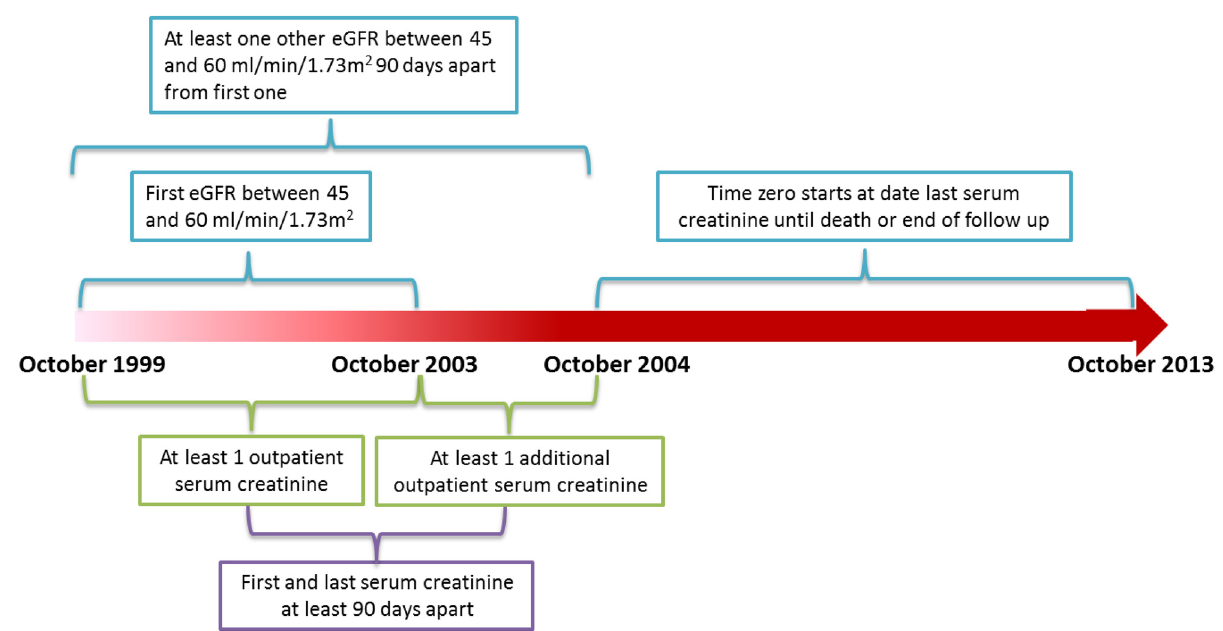
Fig 1. Cohort design and